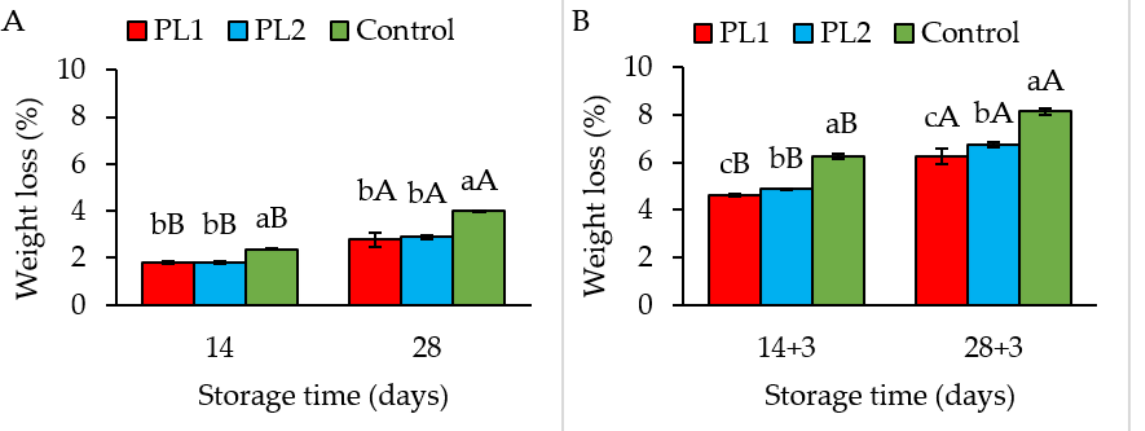
Figure 1. Weight loss changes during the cold storage ( A ) and shelf life ( B ). Data are the mean ± SE of three replicates of twenty-two fruit. Different uppercase letters indicate significant differences for each atmosphere composition during storage, and different lowercase letters indicate significant differences between atmosphere compositions for each sampling date at p < 0.05.